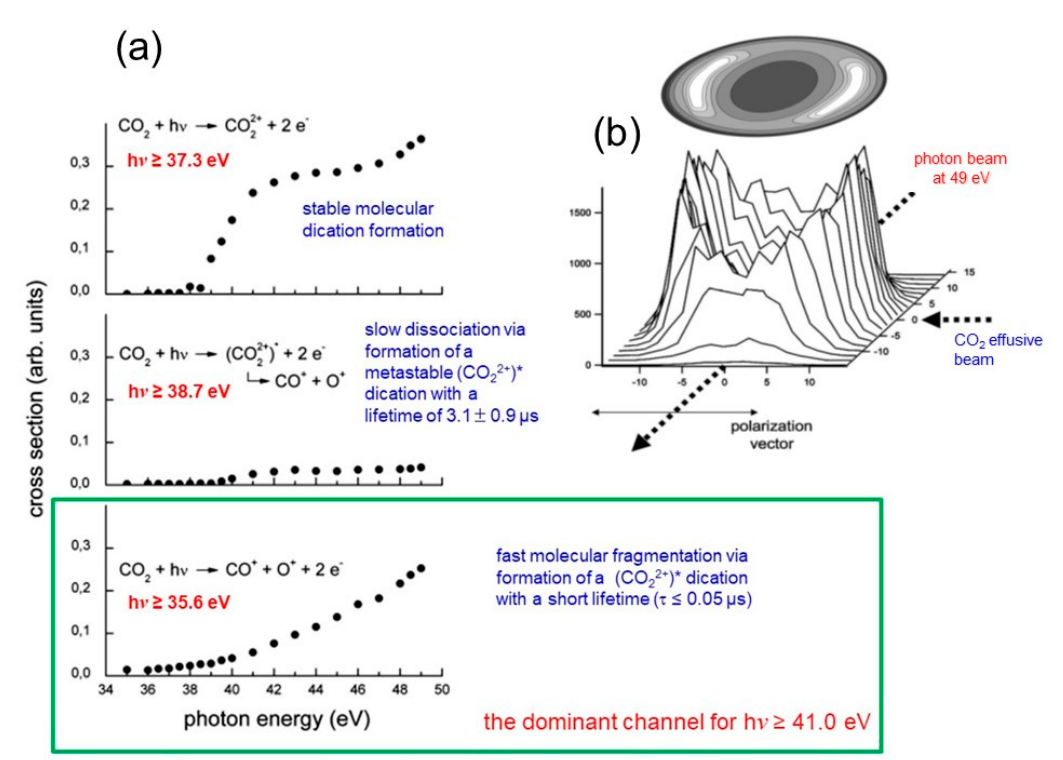
Figure 7. Some typical data obtainable in the double photoionization experiments performed using the PEPIPICO device of Figure 6: ( a ) the relative cross sections as a function of the investigated photon energy obtained in the case of CO 2 [77]; in this experiment, two different metastable CO 22+ dications were detected and the relative lifetimes were measured (for details see ref. [77]); ( b ) an example of the typical 3D representation of the angular distribution for CO + / O + ions products recorded at a photon energy of 49 eV [78].